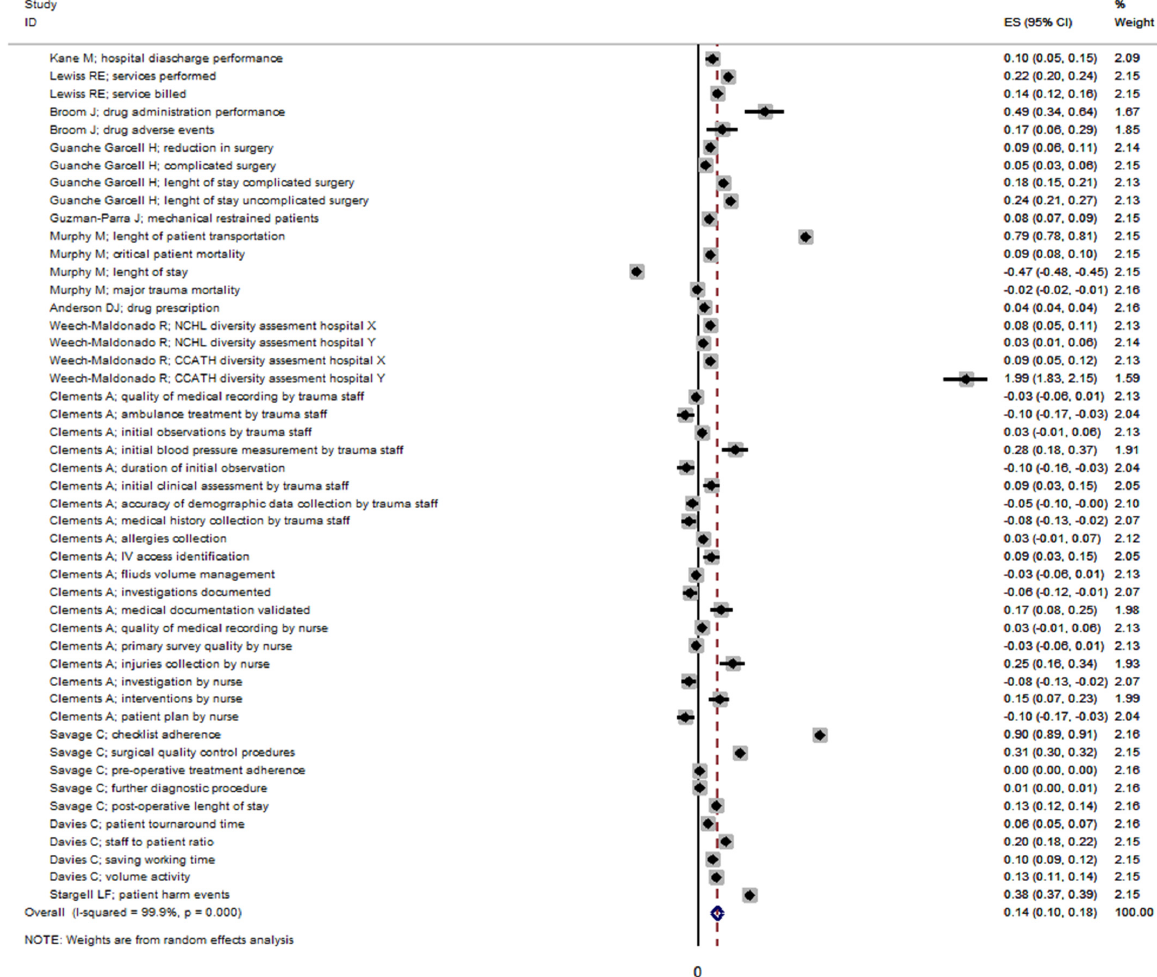
Figure 2. Effectiveness of leadership in before after studies. Dashed line represents the pooled effectiveness value [29,31–41].